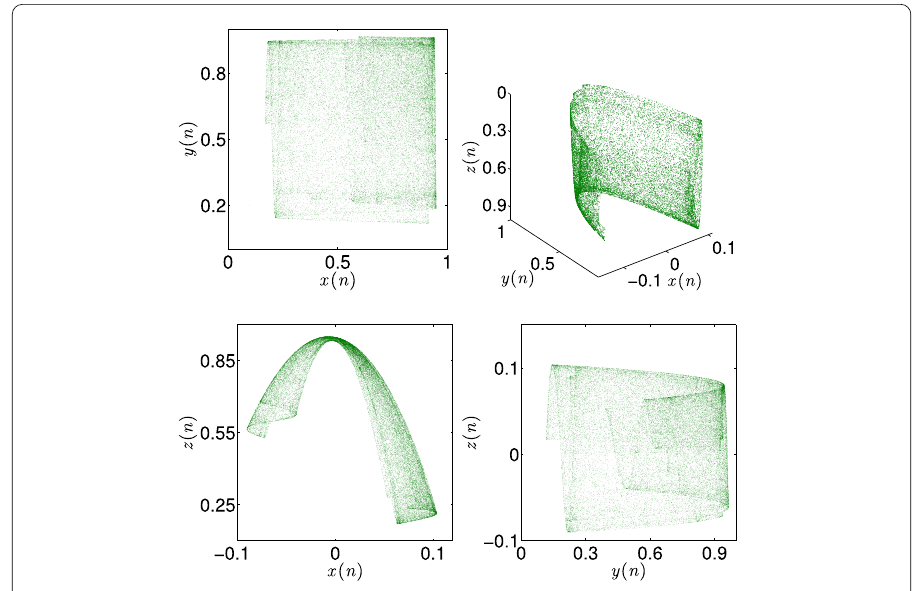
Figure 8 Phase space portraits of the standard Rössler map for b 1 = 3.8, b 2 = 0.05, b 3 = 0.35, b 4 = 3.78, b 5 = 0.2, b 6 = 0.1, and b 7 =